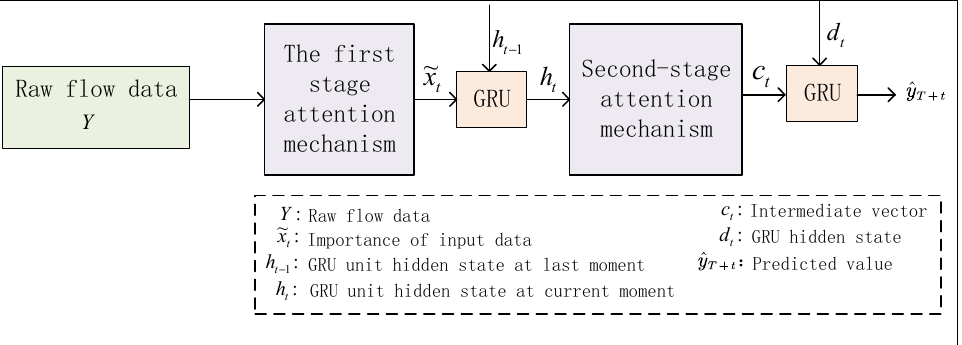
Figure 2. Traffic prediction model of AT-GRU satellite network.